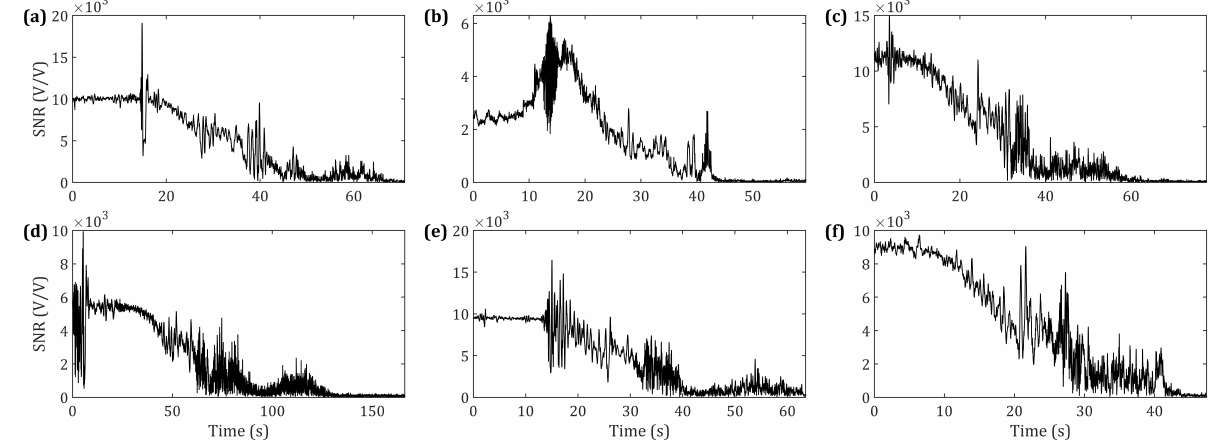
Figure 4. Removed RO measurements.